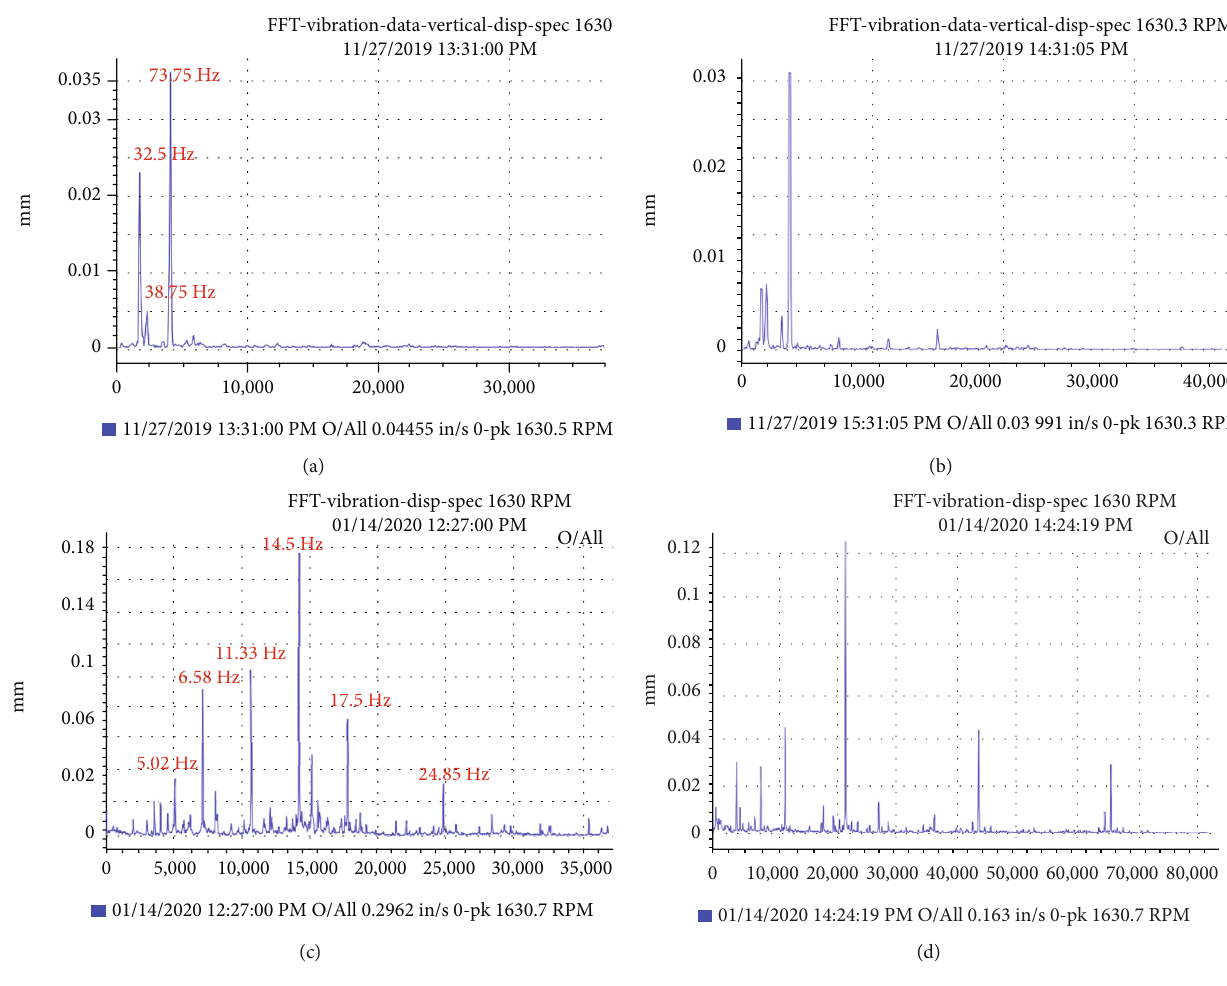
Figure 10: Experimental frequency spectrum of the unbalanced shaft under fl uid-rubbing coupling